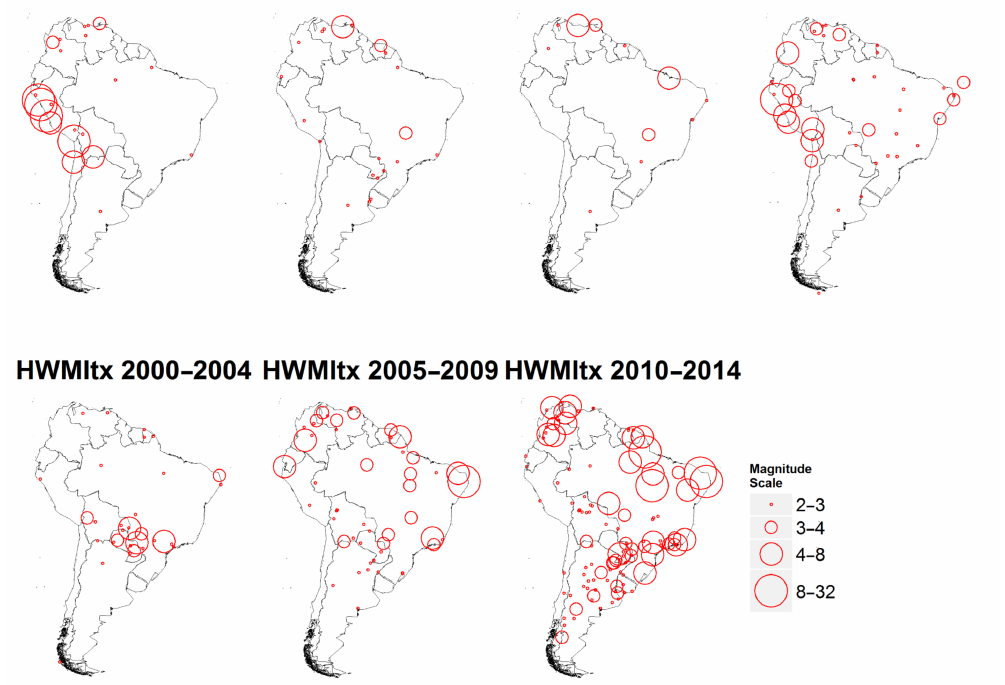
Figure 2. Heat Wave Magnitude Index of maximum temperatures (HWMI tx ) for 5-year periods from 1980 to 2014. The magnitude scale follows the classification of heat waves provided in Table